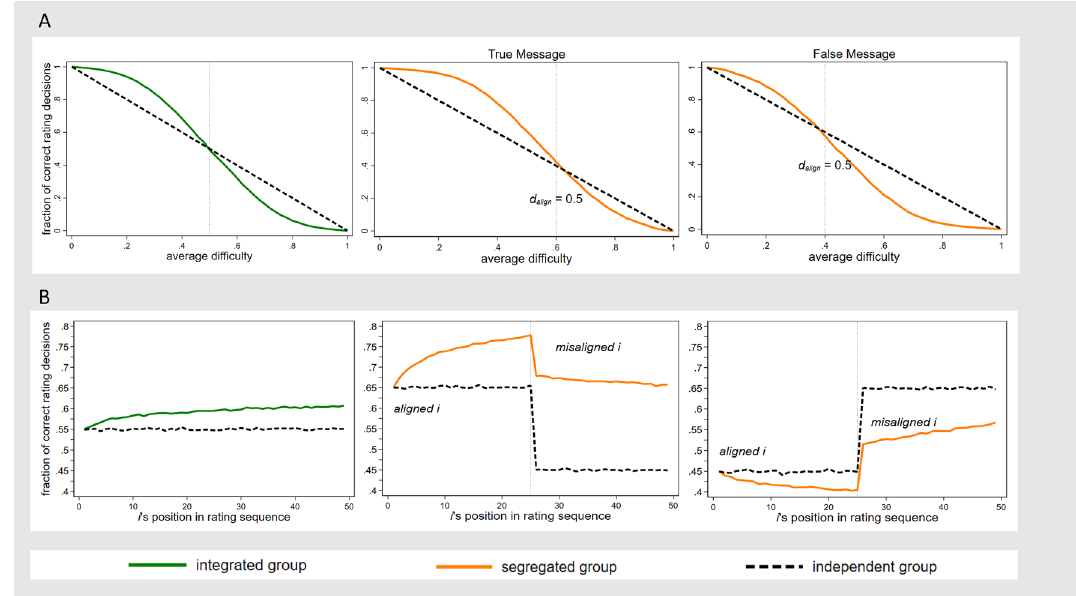
Figure 2. Theoretical expectations. We simulate sequences of rating decisions in 30,000 groups of bipartisan agents (25 ideologically aligned and 25 misaligned agents per group). The fraction of correct rating decisions is shown ( A ) as a function of difficulty and ( B ) as a function of an agents’ position in the rating sequence. In integrated groups, agents classify messages more often correctly than those in independent groups when average difficulty d < 0.5, irrespective of message veracity. In segregated groups, agents classify messages more often correctly than those in independent groups if true messages are being rated but classify messages less often correctly if false messages are rated. Parameters used in all panels: | d align — d mis |= b = 0.2, v = [− 1; 1], s = [0; 2.35]. Panel B: d =